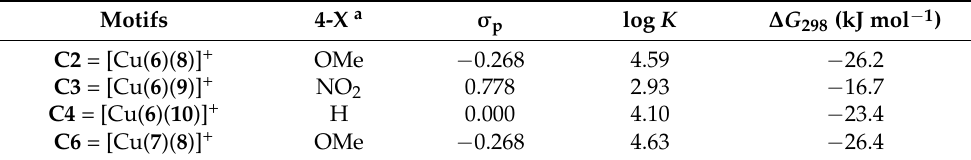
Table 1. Substituent constants, binding constants and Gibbs free energy of C2 – C4 and C6 , as deter- mined from UV–Vis titrations.